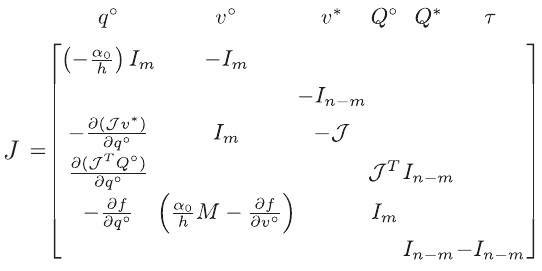
Figure 3. Jacobian